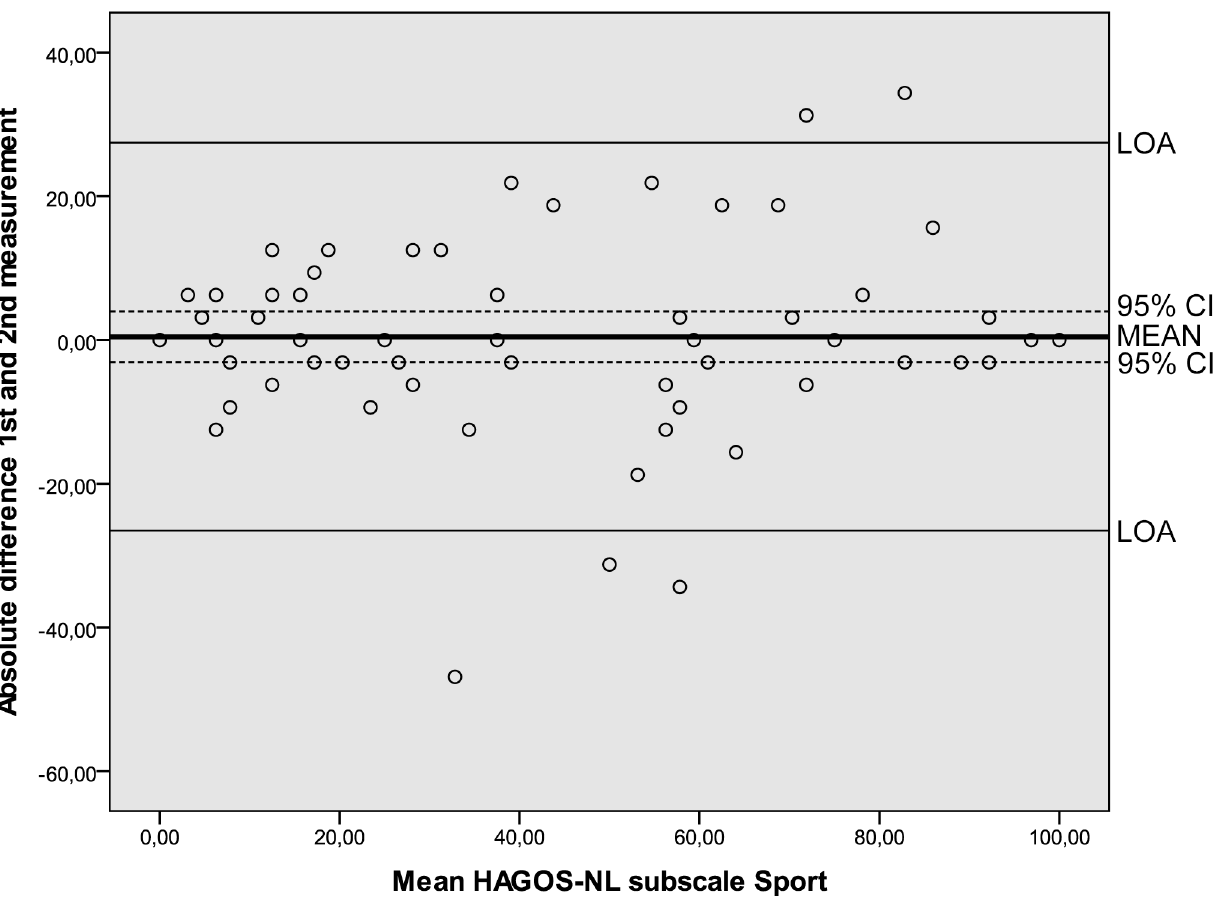
Fig 5. Bland and Altman graph of HAGOS subscale Sport . Abbreviations: HAGOS, Copenhagen Hip And Groin Outcome Score; LOA, limits of agreement; 95% CI, 95% confidenceinterval.